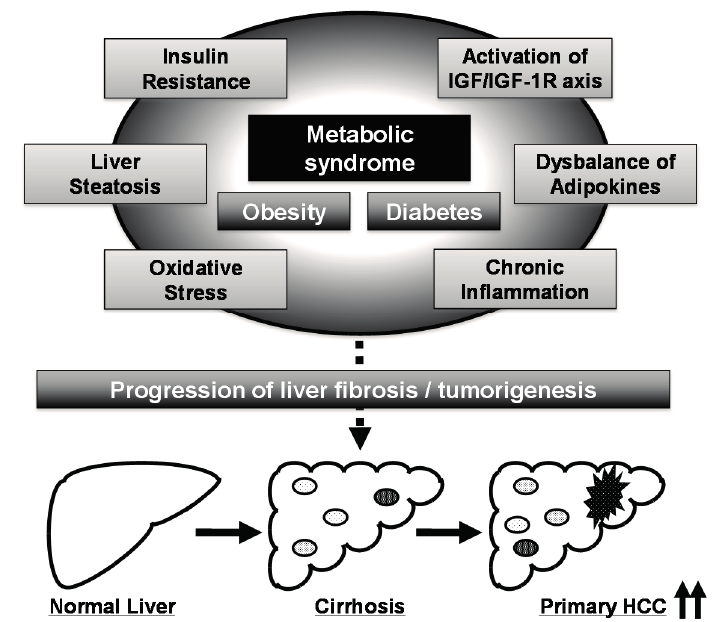
Figure 1. Proposed mechanisms linking metabolic syndrome and liver carcinogenesis. The black arrows at the right corner mean the incidence of hepatocellular carcinoma (HCC) is